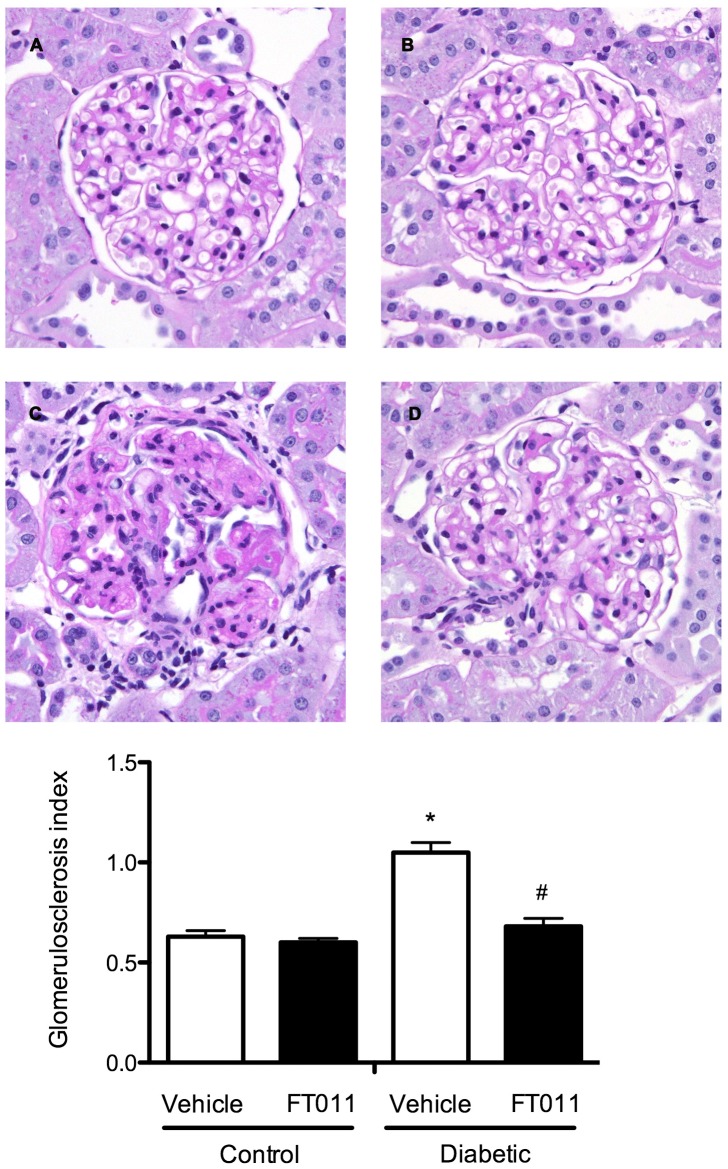
Representative photomicrograph of PAS stained sections from diabetic rats.Representative photomicrographs of PAS stained kidney sections from control (A) and control animals treated with FT011 (B), diabetes (C) and diabetic rats treated with FT011 (D). Compared with control animals, untreated diabetic rats (C) demonstrated marked glomerulosclerosis characterised by diffuse and nodular glomerulosclerosis. FT011 treated diabetic rats (D) demonstrated near normal glomerular histology. Magnification, ×400; Glomerulosclerotic index data are expressed as mean ± SEM. *P<0.05 versus control; #
P<0.05 versus vehicle treated diabetic rats.